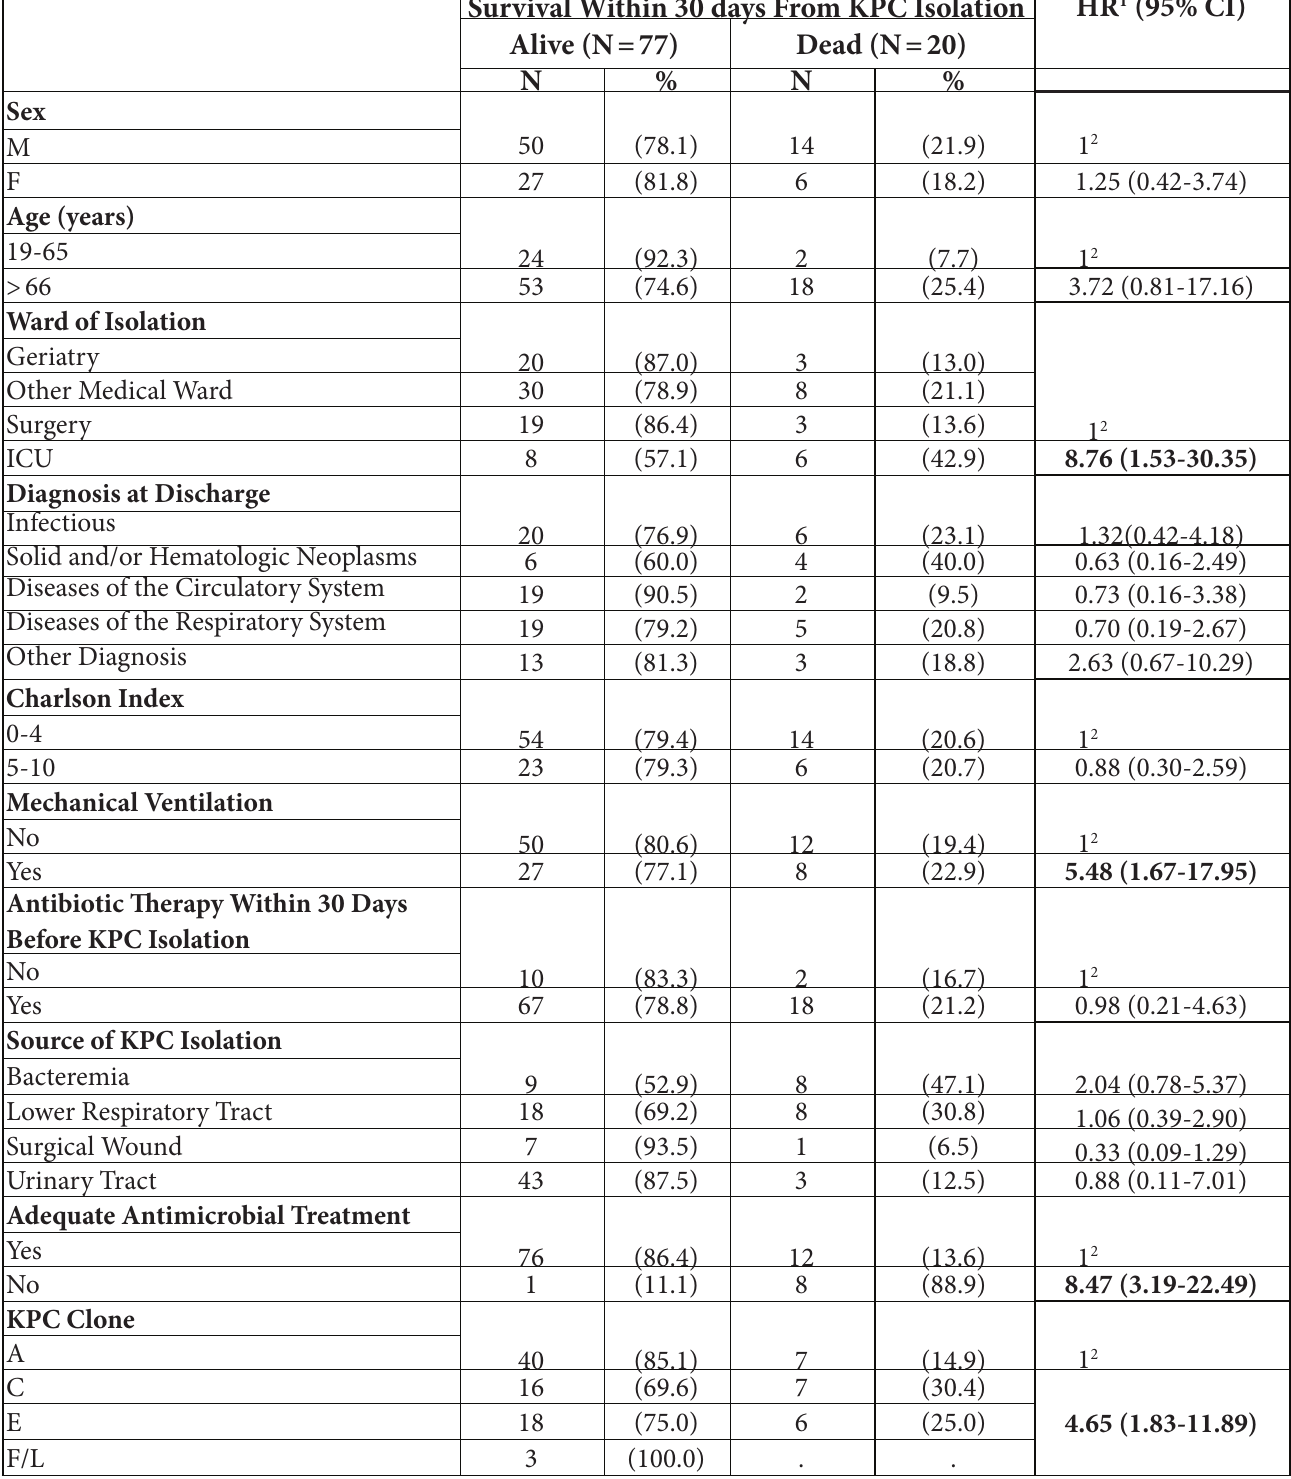
Table 3. Distribution of major patient characteristics according to the outcome of death within 30 days from KPC- Kp isolation and the associated hazard ratio (HR) and 95% confidence intervals (CI)